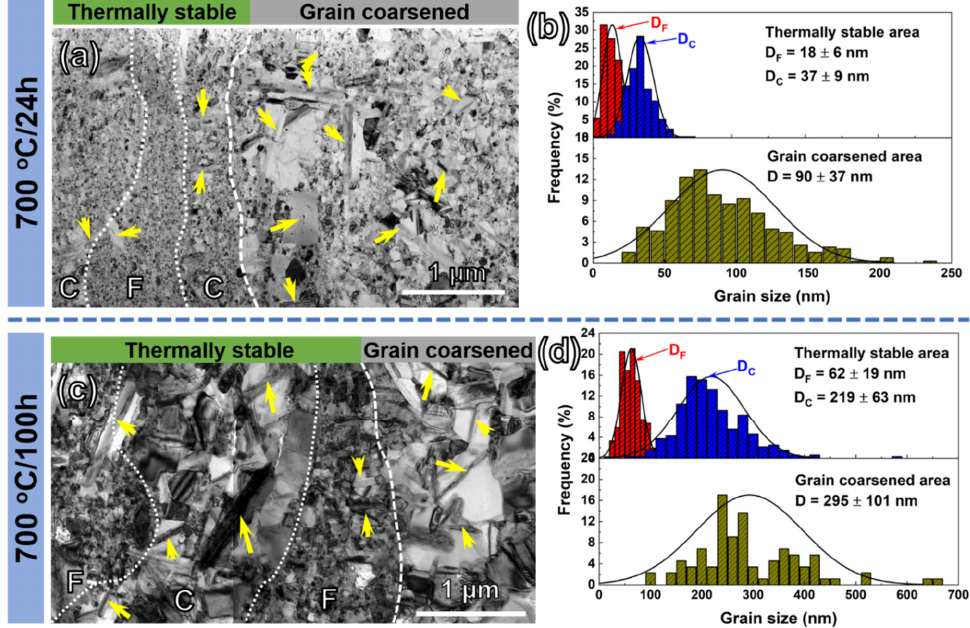
Figure 3. TEM images showing the sharp interface formed between the thermally stable area and the grain coarsened area of NG IN718 specimens after annealing at 700 °C for ( a ) 24 h and ( c ) 100 h. ( b , d ) The corresponding statistic distributions revealing the average grain sizes of FNG (D F ) and CNG (D C ) layers in the thermally stable and grain coarsened area.